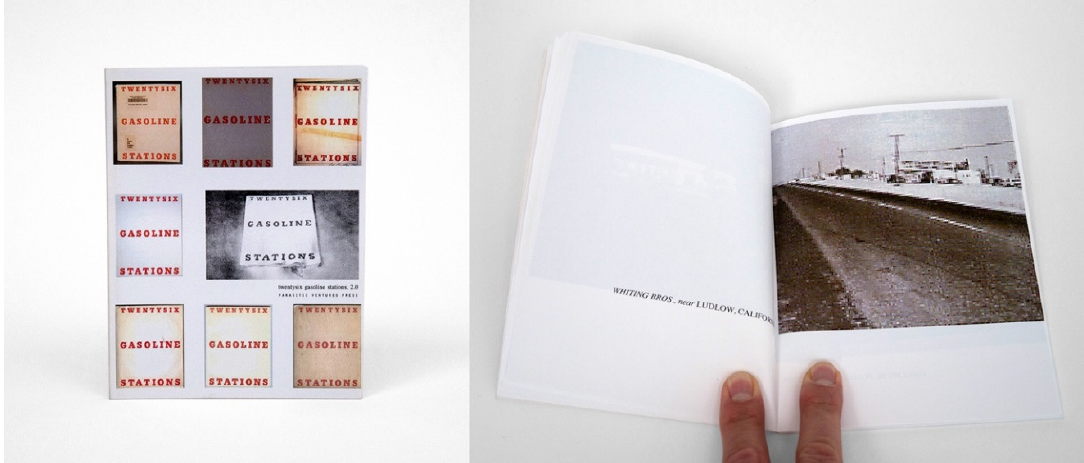
Arts 2019 , 8 , x FOR PEER REVIEW Figure 17. Michael Maranda, Twentysix Gasoline Stations 2.0 , 2010. Figure 17. Michael Maranda, Twentysix Gasoline Stations 2.0 , 2010.